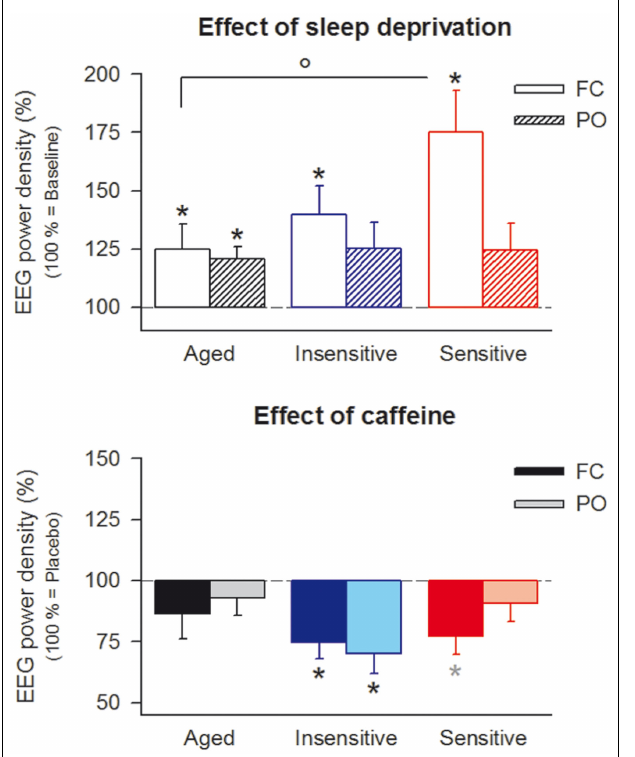
FIGURE 2 | Effects of sleep deprivation and caffeine on theta power (6.25–8.25Hz) in the waking EEG (eyes open) in fronto-central (FC, open bars) and parieto-occipital (PO, striped bars) derivations in aged ( n = 10, black bars) and caffeine-insensitive ( n = 10, blue bars) and -sensitive ( n = 12, red bars) young men. Upper panel : to quantify the effect of sleep deprivation, theta activity after sleep deprivation in the placebo condition was expressed as a percentage of the corresponding baseline value. Data represent means ± SEM.Three-way mixed-model ANOVA with the factors “ group ” (age, insensitive, sensitive), “ deprivation ” (sleep deprivation, baseline), and “ derivation ” (FC, PO) revealed significant main effects of “ deprivation ” ( F 1,66.1 = 19.8, p < 0.001) and “ derivation ” ( F 1,48.8 = 4.8, p < 0.04), as well as a significant “ group ” × “ derivation ” interaction ( F